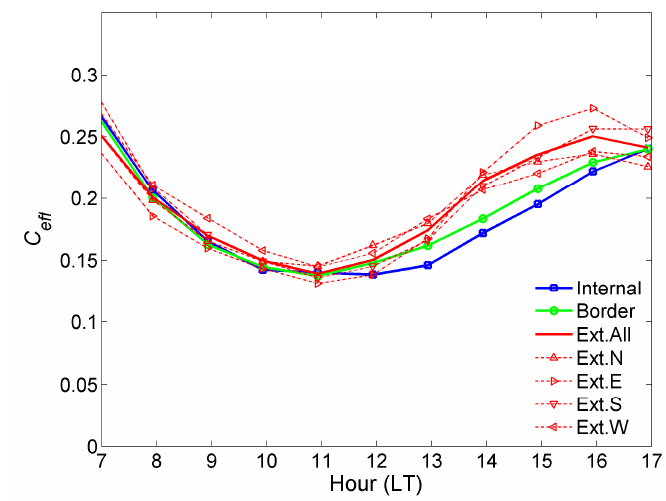
Figure 9. Hourly averaged cloudiness C ef f for the target areas at Serra da Mesa reservoir during the year of 2018.